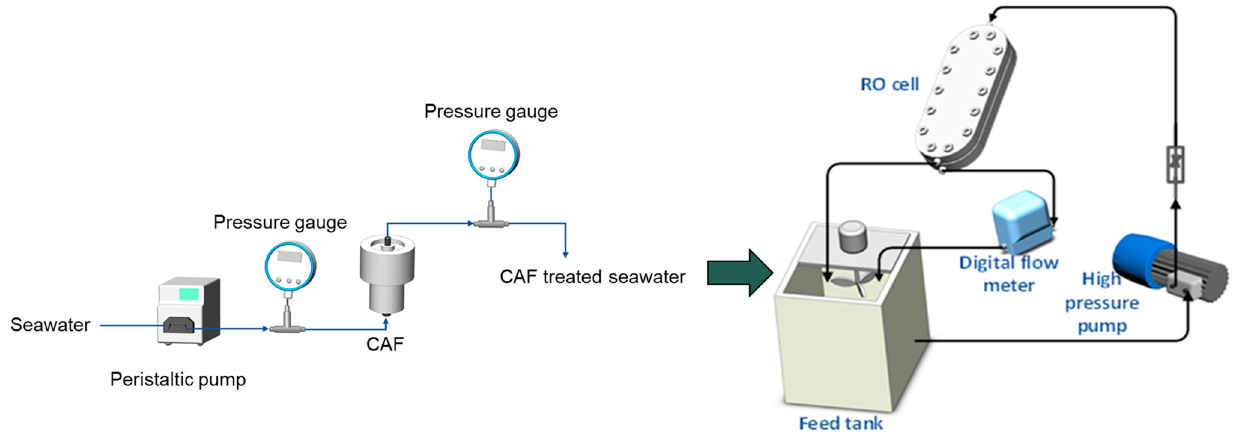
Figure 2. Schematic of the experimental setup with CAF